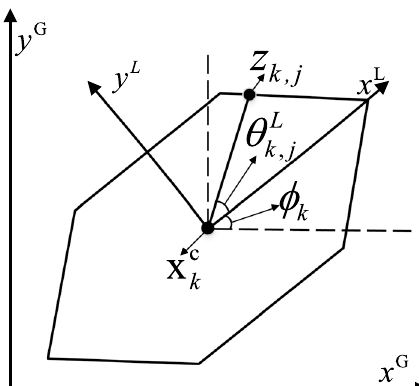
Fig. 1 Geometric relationship between θ L k , j , z k , j , and φ